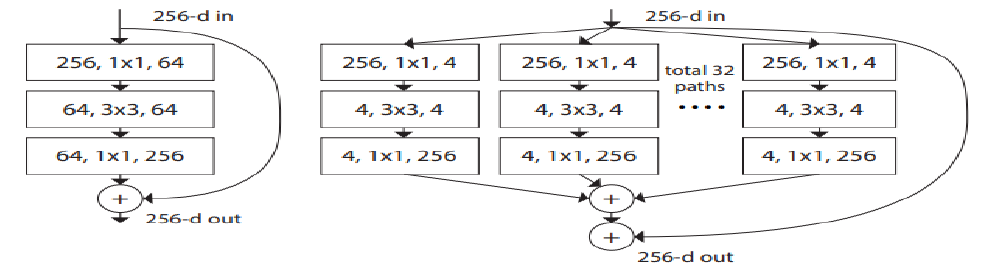
Figure 2. (Left): A building block of ResNet [43]. (Right): A block of ResNeXt with a given cardinality (here 32) [33]. A layer is shown as (# in channels, filter size, # out channels). These two blocks have roughly the same complexity.